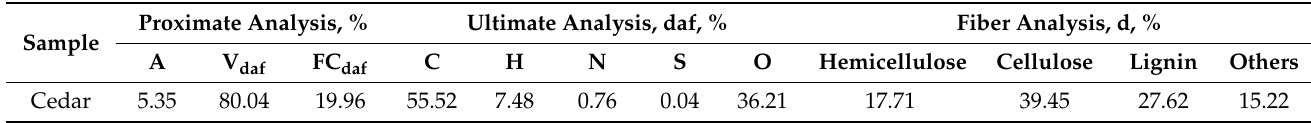
Table 1. Fundamental analysis of